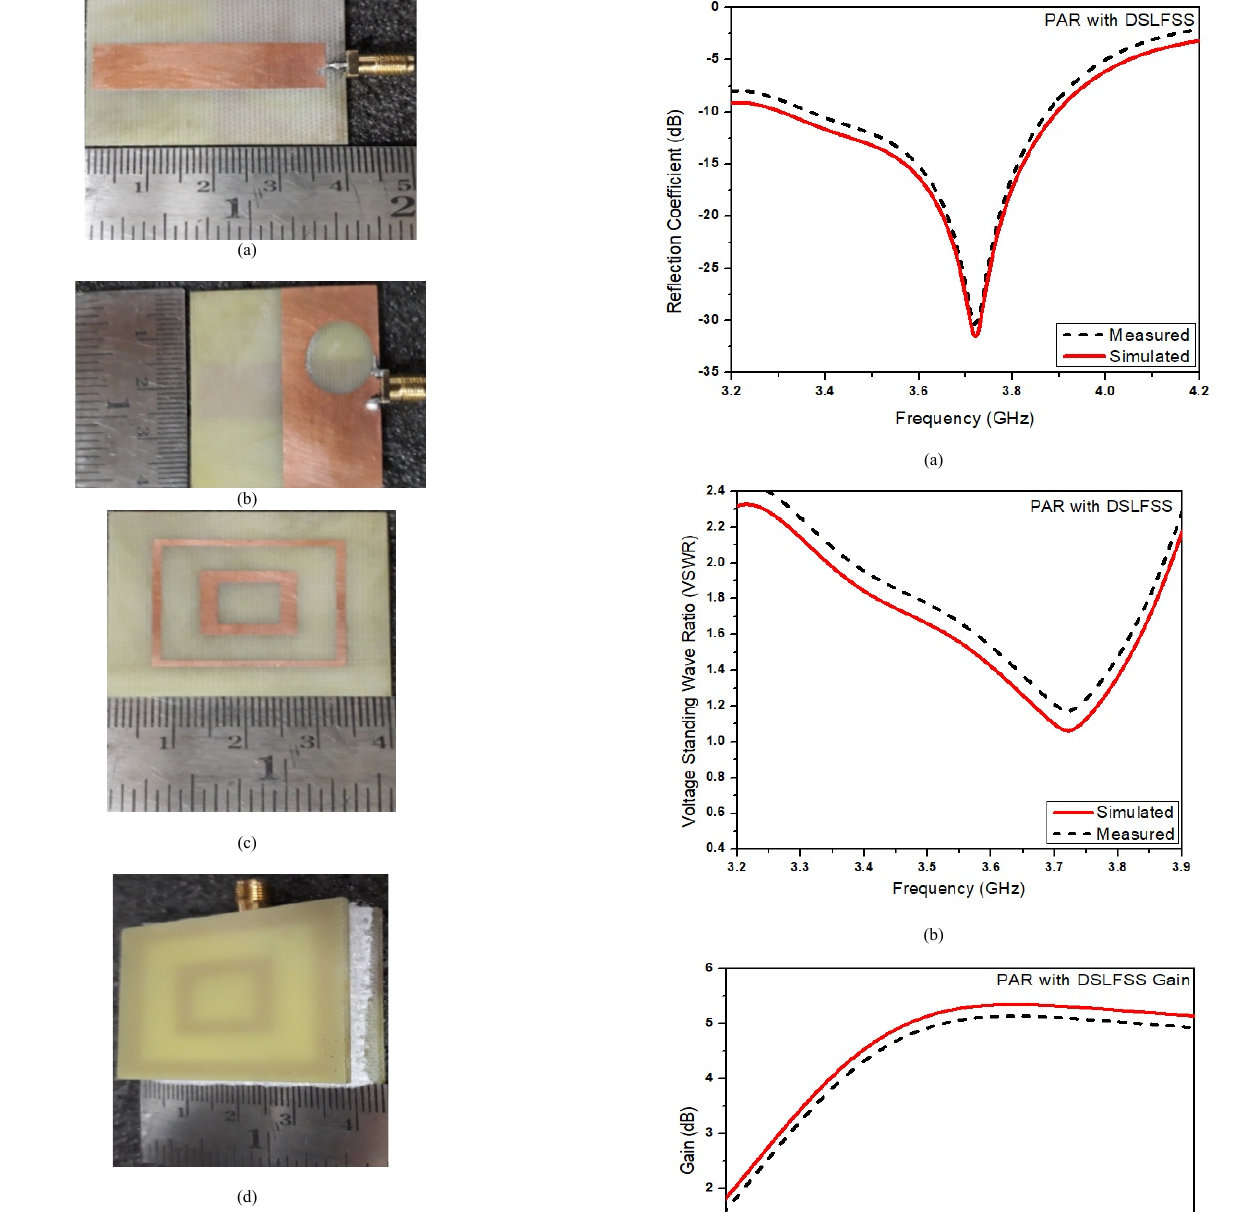
FIGURE 7: Fabricated antenna (a) front view of PAR, (b) back view of PAR, (c) DSLFSS unit cell and (d) stacked PAR with DSLFSS. The results in terms of of reflection coefficient, VSWR, gain and directivity retrieved from measurements are averaged and plotted in comparison to the simulation results as reported with in Figure 8 for the PAR design with